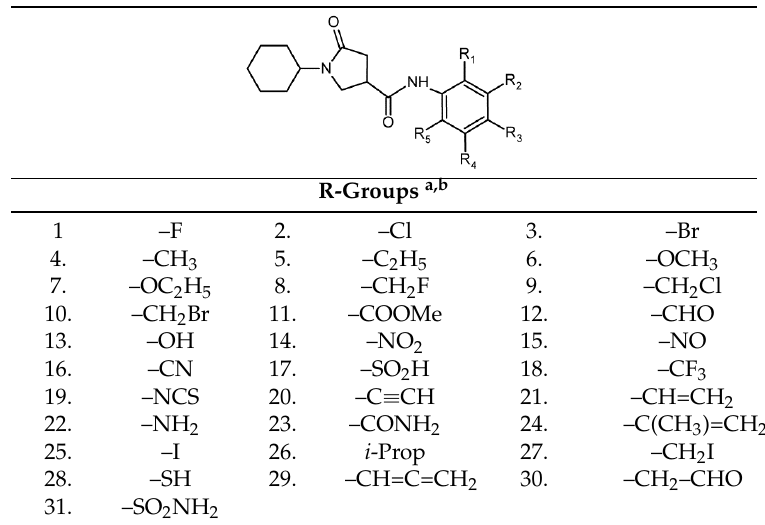
Table 5. R-groups (fragments, building blocks, substituents) used in the design of the initial diversity library of PCAM analogues.